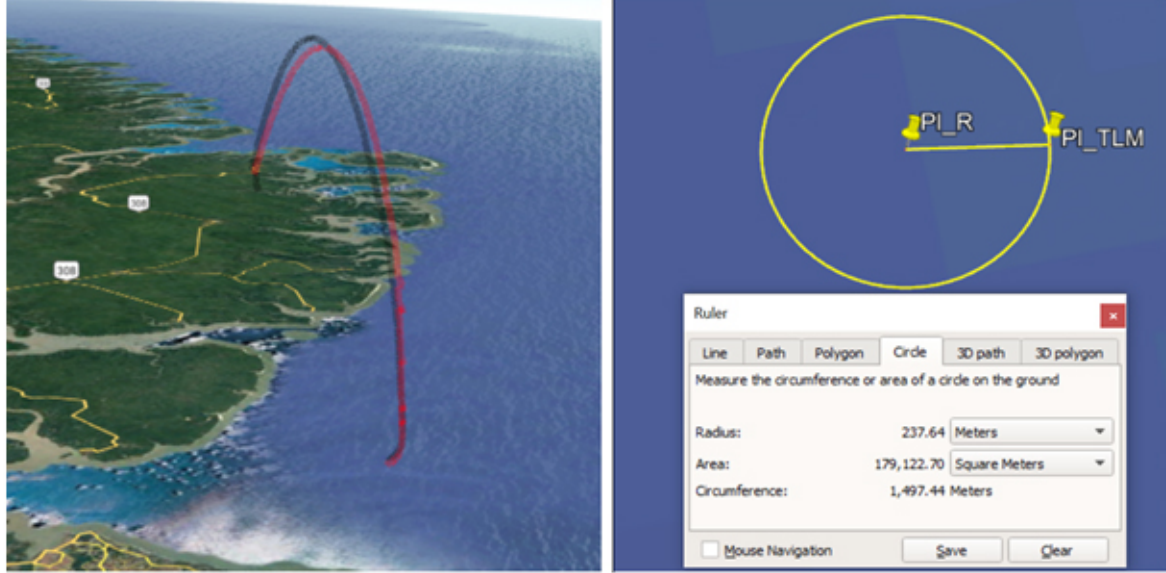
Figure 9. Comparison of points of impacts generated by the radar in relation to the Telemetry-Slant Range set.